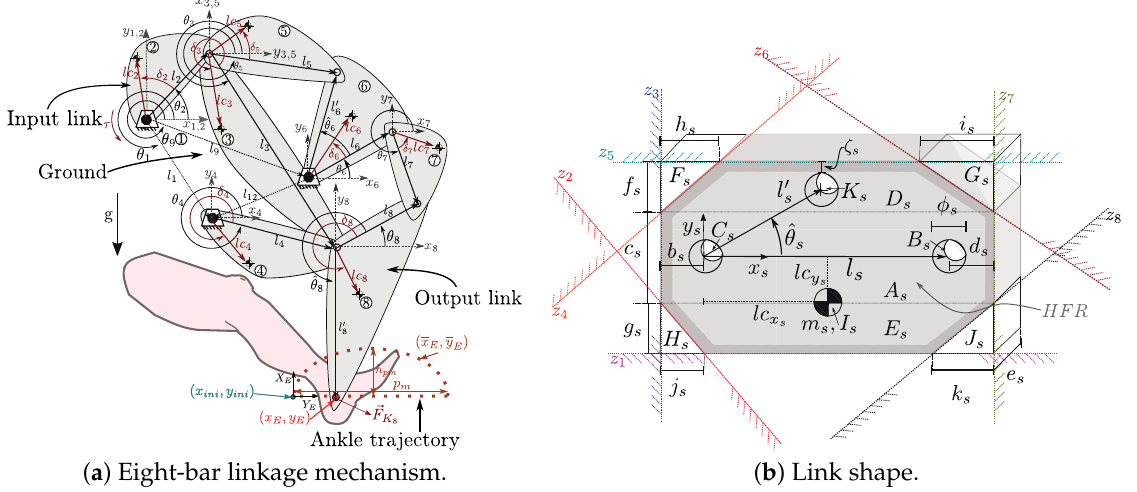
Figure 4. Eight-bar linkage mechanism and the link